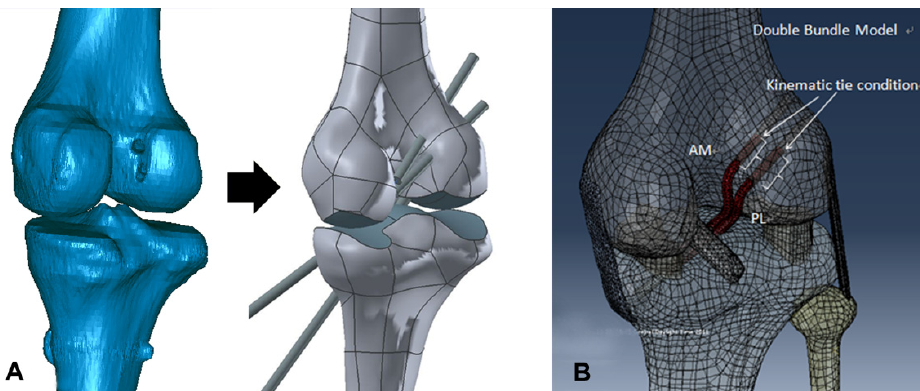
Figure 3. ( A ) Computed tomography (CT) images of each group were used for 3D reconstruction in Mimics. To simulate single-bundle or double-bundle ACL reconstructions in the 0° analytic model, tunnels were reamed at the center of tunnels of the femur and tibia of the validation model using the average femoral tunnel position measured by Bernard’s quadrant method [24] and drilled according to the femoral tunnel direction, estimated by the femoral graft bending angle described by Wang et al. [11] ( B ) The reconstructed ACL was attached to the femoral and tibial tunnels in the model.